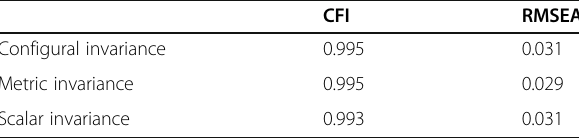
Table 7 Global fit measures from the SCFA of attitudes toward Muslim and black